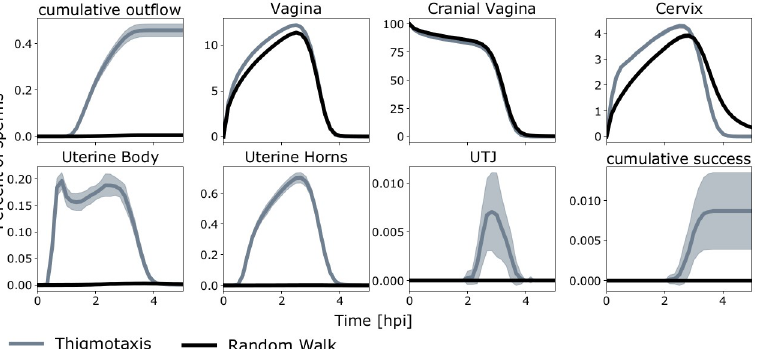
Fig 4. Agent dynamics in different compartments (in %). Upper left and lower right: cumulative time courses of agents being removed from the simulation due to negative z-values (outflow) or reaching the oviducts, respectively. Shaded areas indicate standard deviation. Initially, all agents are located in the cranial vagina. Ultimately, almost all agents were removed by the immune